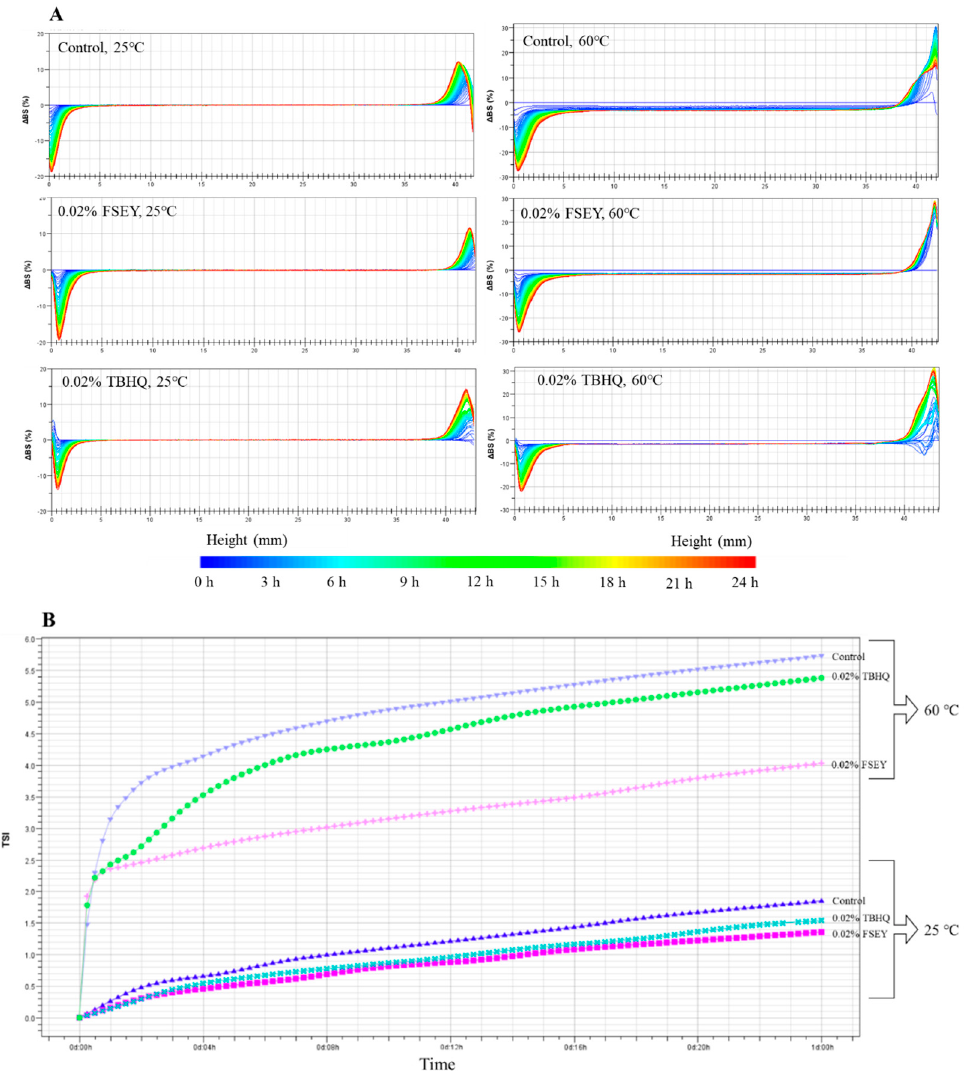
Figure 7. ( A ) Delta backscattering of oil − in − water emulsions, in the absence or in the presence of temperatures. ( B ) Turbiscan stability index of the oil-in-water emulsions. These data are represented as a function of time antioxidants, in different temperatures. ( B ) Turbiscan stability index of the oil − in − water emul ‐ (0:00 to 24:00 h) and of sample height (0 to 42 sions. These data are represented as a function of time (0:00 to 24:00 h) and of sample height (0 to 42 mm).